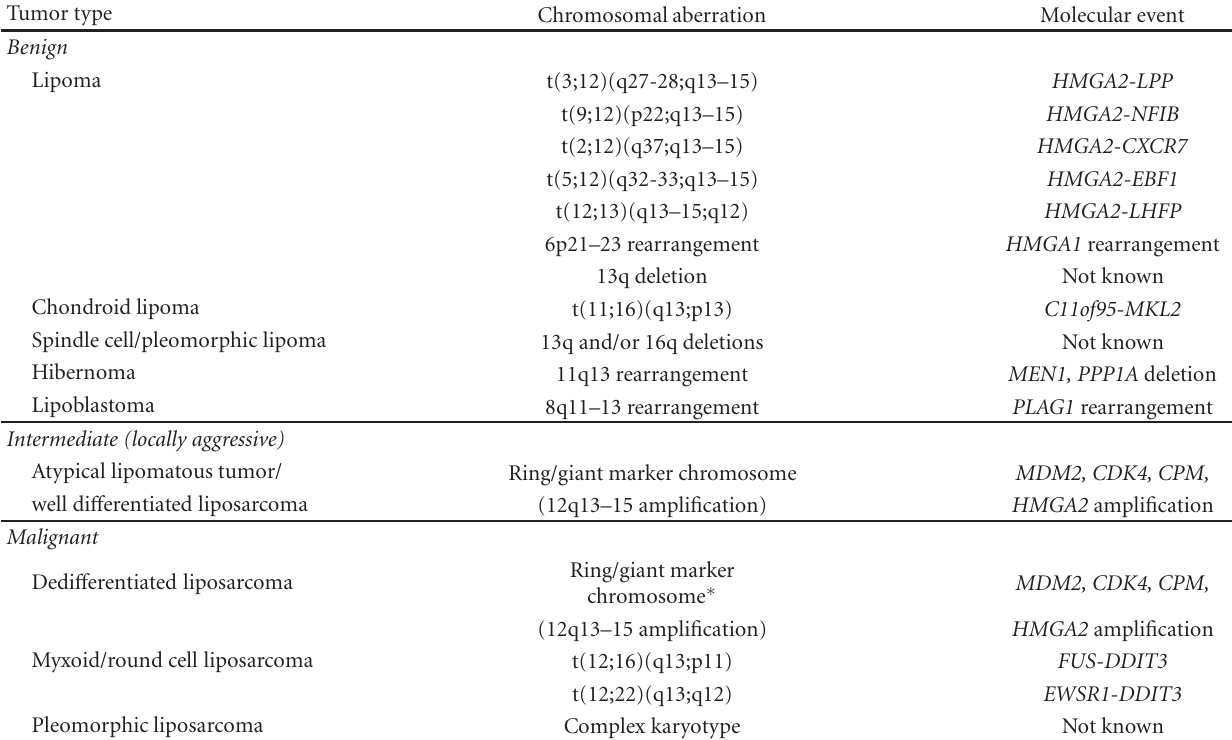
Table 1: Chromosomal aberrations and associated molecular events in adipocytic